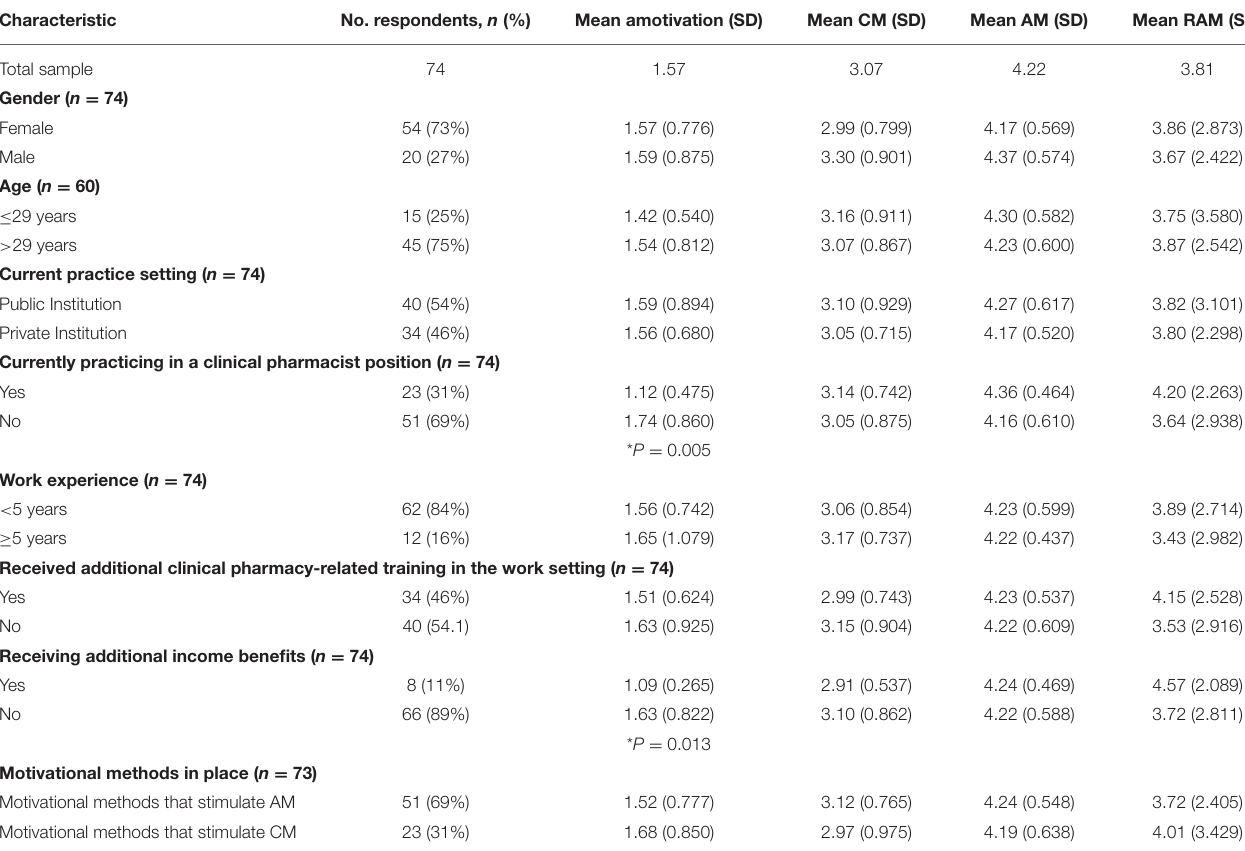
TABLE 1 | Mean scores of clinical pharmacy graduates on autonomous motivation (AM), controlled motivation (CM), and amotivation.